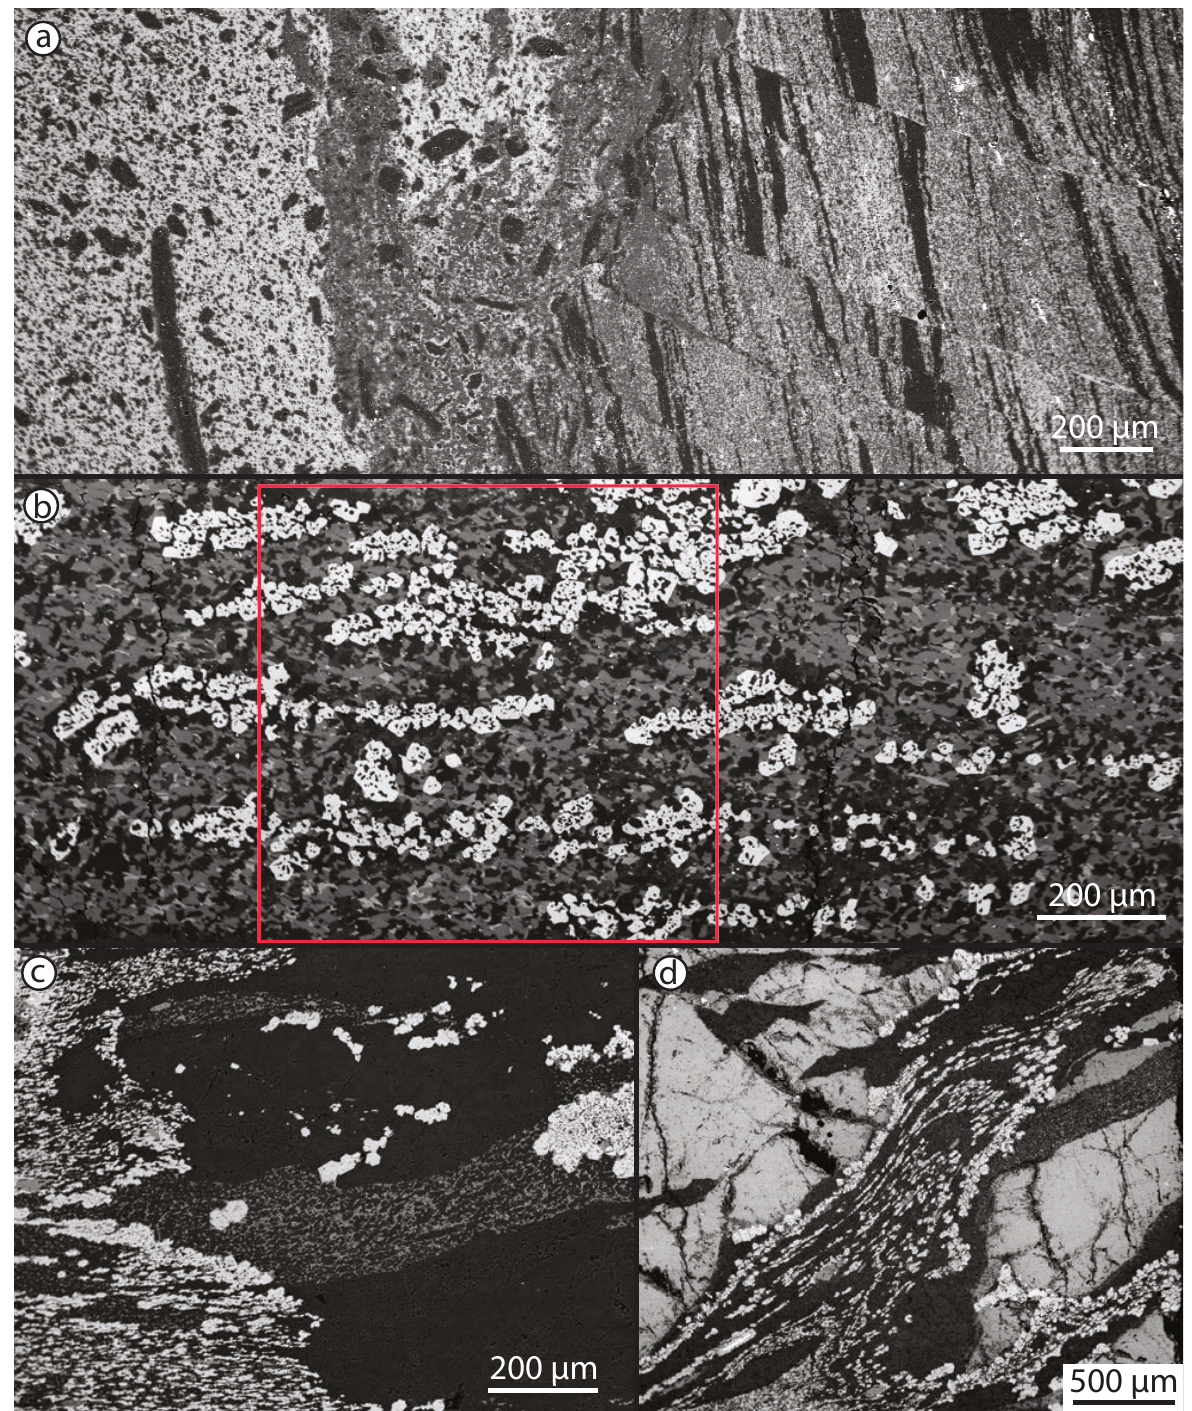
Figure 5. Backscattered electron images of pseudotachylyte: (a) late-stage pseudotachylyte with angular clasts in mylonitic host rock with abundant fractures (26.3550S, 131.8432E). (b) Dynamically recrystallized pseudotachylyte in sample F68. Minerals in greyscale from dark to bright are Qz, Pl, Kfs, Ky, Bt, and Grt. The red box indicates the mapped area for Fig. 7. (c) Un-sheared pseudotachylyte in a vein cutting through a plagioclase grain of the granulitic host rock showing dendritic overgrowth of garnet. In the left part of the image, the pseudotachylyte is finely grained and foliated (sample S5). (d) Injection vein preserves original flow banding, visible through the selective overgrowth of garnet (sample